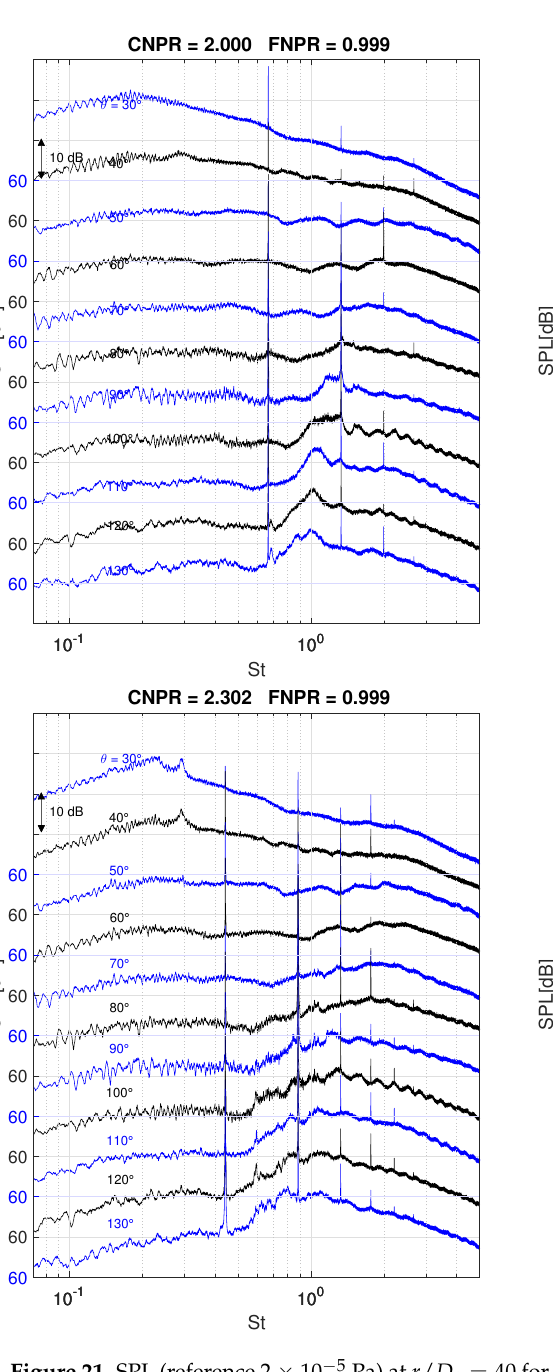
Figure 21. SPL (reference 2 × 10 − 5 Pa) at r / D 1 = 40 for CNPR = 2.00 M j = 1.05 ( top left ), CNPR = 2.26 M j = 1.15 ( top right ), CNPR = 2.30 M j = 1.16 ( bottom left ) and CNPR = 3.67 M j = 1.50 (bottom right) at all the measured angles, nozzle diameter D 1 = 0.0240 m. The images show the switching between two screech modes, from the axisymmetric ( top left ) to the flapping mode ( top right ). Many harmonics of the screech tones are visible, and for CNPR = 2.26 also three subharmonics are present. Increasing the Mach number the screech mode switch completely to the flapping mode ( bottom left ), and then to the helical mode ( bottom right